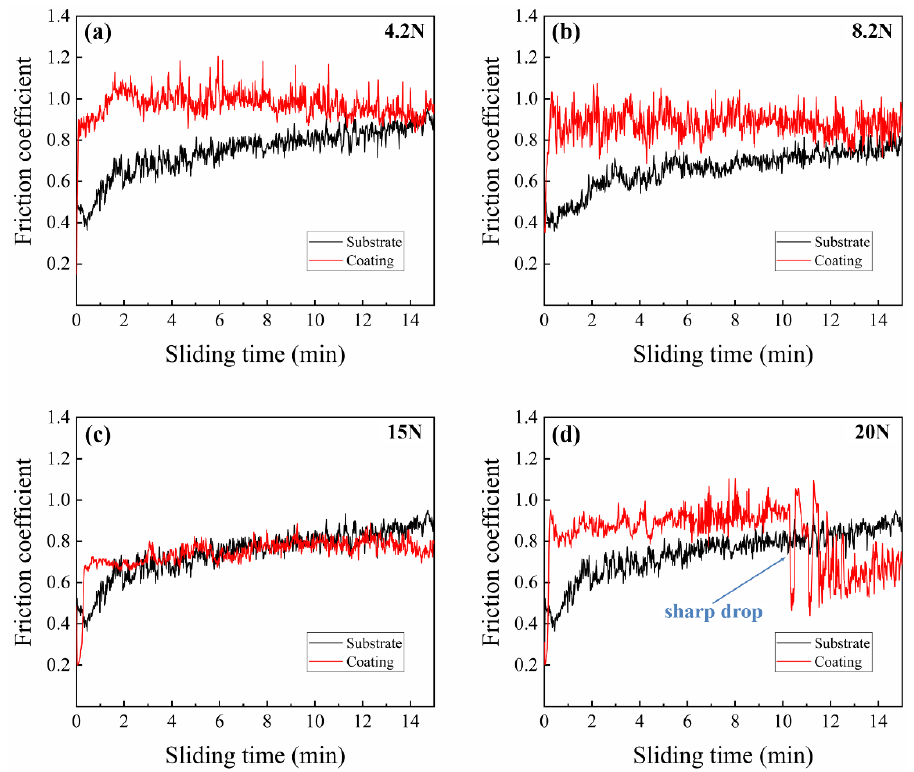
Figure 7. Coefficients of friction of substrate and composite coating specimens under different axial loads: ( a ) 4.2 N; ( b ) 8.2 N; ( c ) 15 N; and ( d ) 20 N.